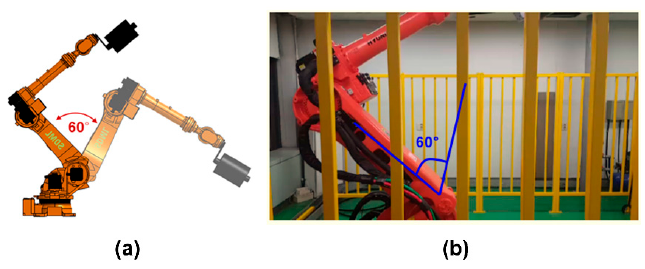
Figure 7. Data acquiring motion of robot shown in ( a ) a graphical image and ( b ) its photograph. Table 1. Data acquisition specifications.